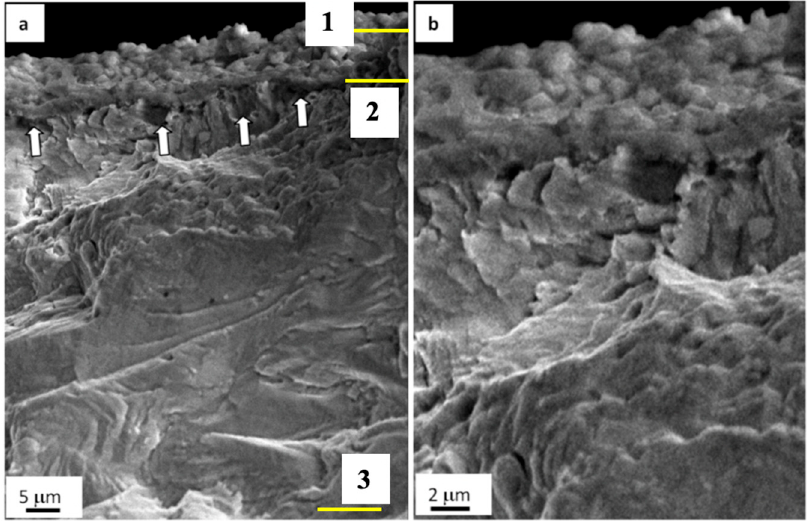
Figure 4. Fractography of the fatigue-fractured surface in AISI 310S steel. Arrows indicate micropores. Numbers show the position of steel objects (films) under TEM study. ( a ) general view; ( b ) enlarged photo.